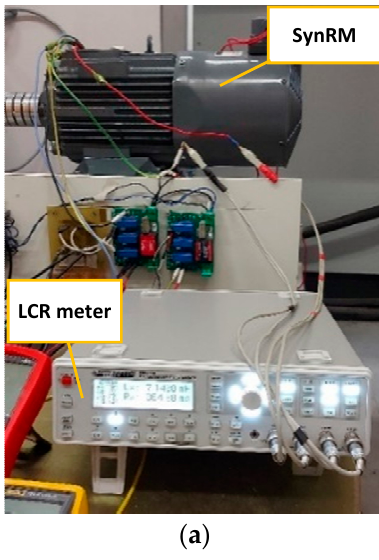
Figure 6. Photograph of a five-synchronous reluctance motor with LCR meter, ( a ) measurement resistance between two adjacent phases and ( b ) nonadjacent phases.